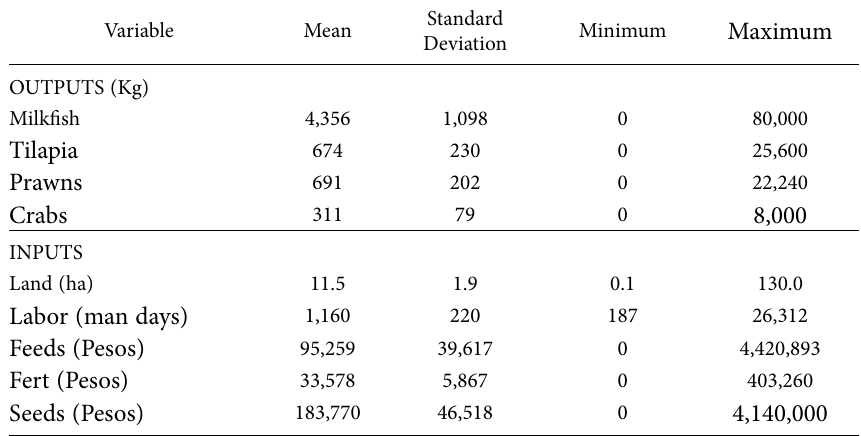
Table 1. Summary